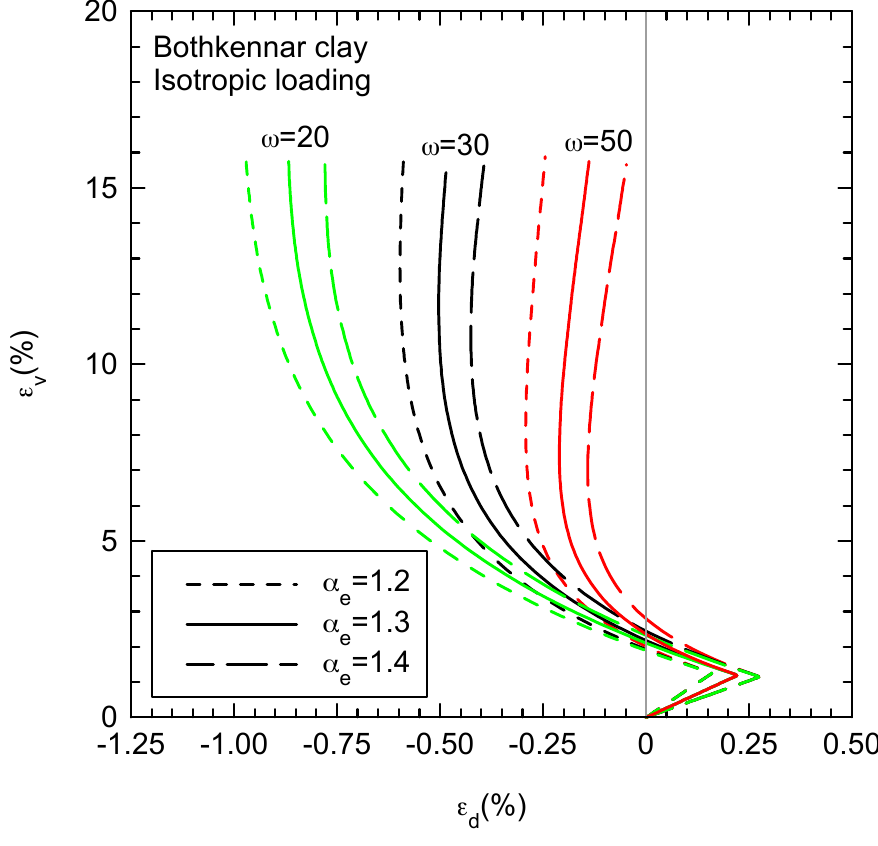
Figure 10. Strain path (ratio between shear and volumetric strains) for compression under constant shear stresses ( dq = 0 ).